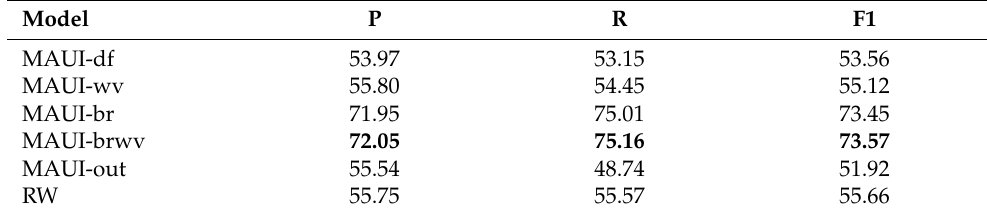
Table 3. Precision, recall and F1-score on MAUI Twitter data set. Scores in bold stand for the